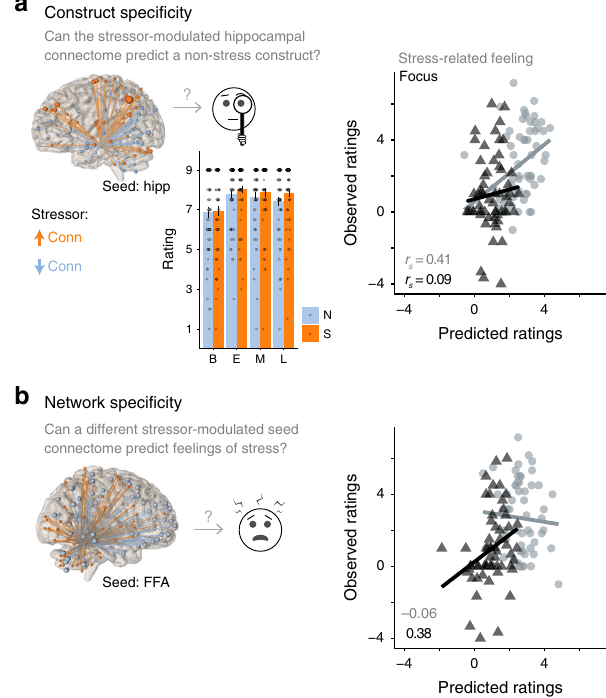
Fig. 4 Hippocampal models show construct and network speci fi city. Representative model is shown here; all models shown in Supplementary Fig. 2. N = 60 participants. Source data are provided as a Source Data fi le. a Construct speci fi city analysis. The control construct (ratings of focus) was collected at the same time as ratings of stress-related feelings and is shown for baseline, early, mid, and late epochs of Stressor and Neutral conditions (analogous to Fig. 1d). Error bars = + 1 SE. Hippocampal networks that successfully predicted stress-related feelings (gray circles) were not able to predict ratings of focus (black triangles) using the same sCPM approach. Correlations near or below zero indicate model failure. b Network speci fi city analysis. The control network (fusiform face area, FFA-seeded connectome) was computed in the same way as the stressor- modulated hippocampal connectome (shown in Fig. 1e). FFA networks did not successfully predict stress-related feelings even when they did predict ratings of